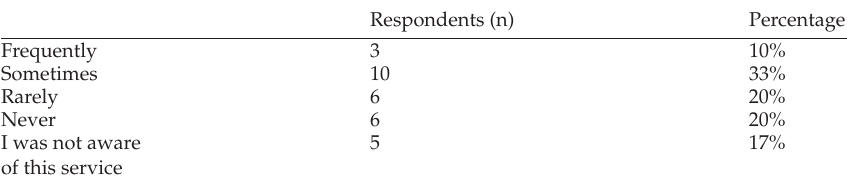
Table 2. Faculty Participation in Collection Development, Yerevan State